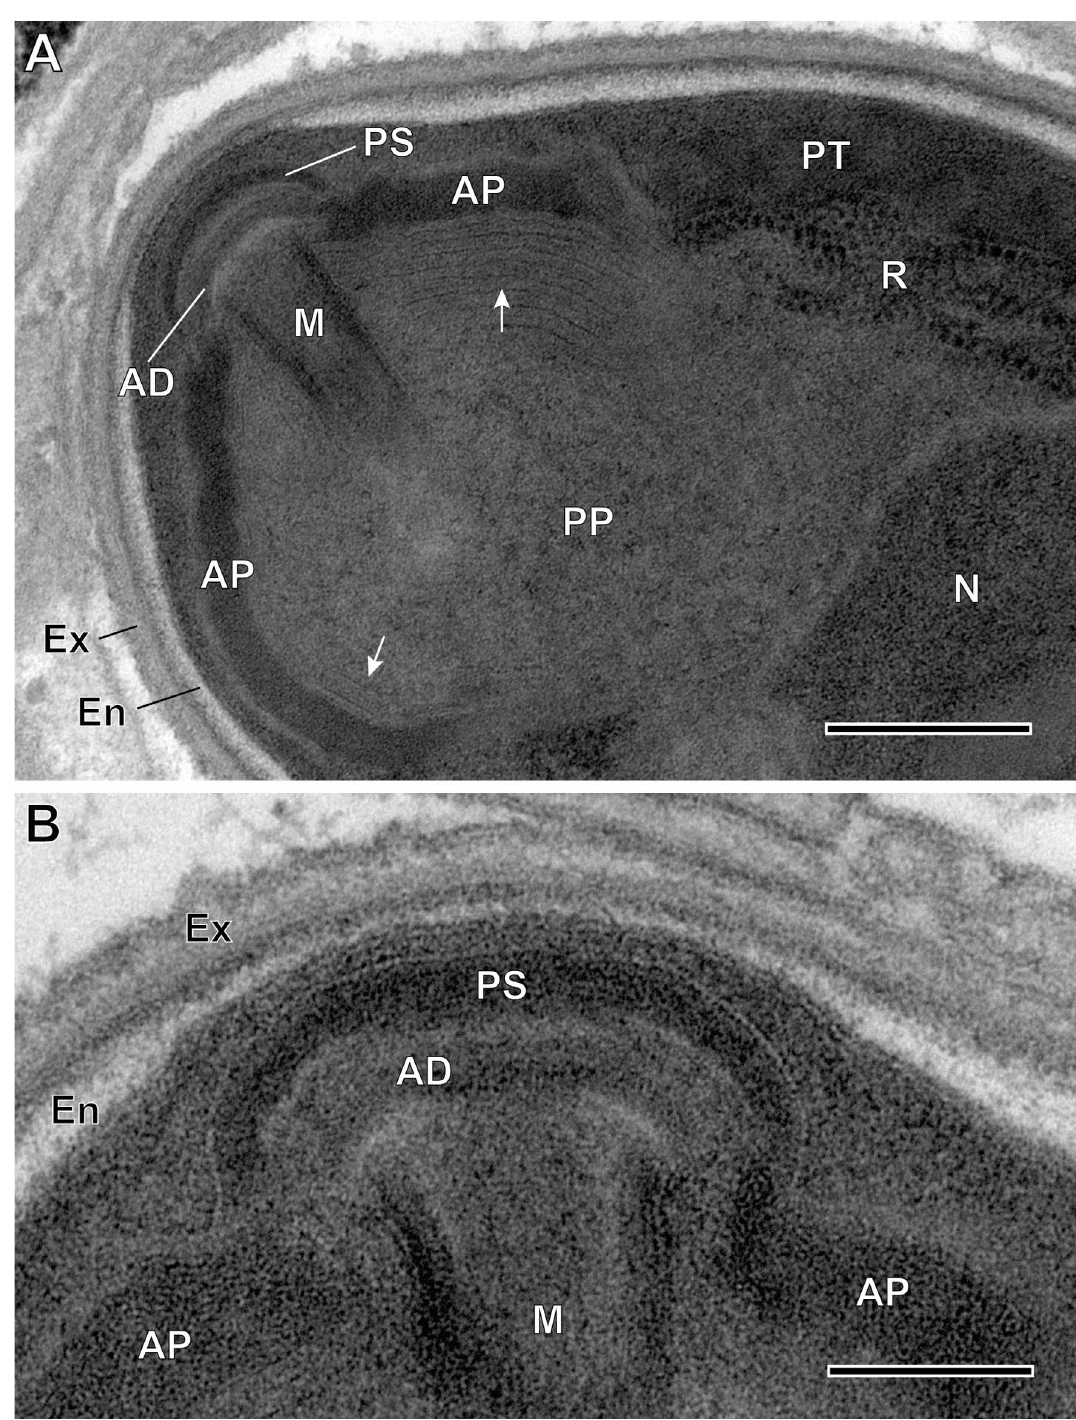
Figure 8. Ultrastructural details of mature spores of Toguebayea baccigeri n. gen., n. sp. (A) Anterior region showing the polaroplast with a lamellar external part (white arrows) and a granular internal part; (B) Enlarged detail of the apical part showing the polar sac (PS) and the anchoring disc (AD). AP, anterior polaroplast; En, endospore; Ex, exospore; M, manubrium; N, nucleus; PP, posterior polaroplast; PT, polar tube; R, ribosomes and polyribosomes. Scale bars: A = 0.25 l m; B = 0.1 l